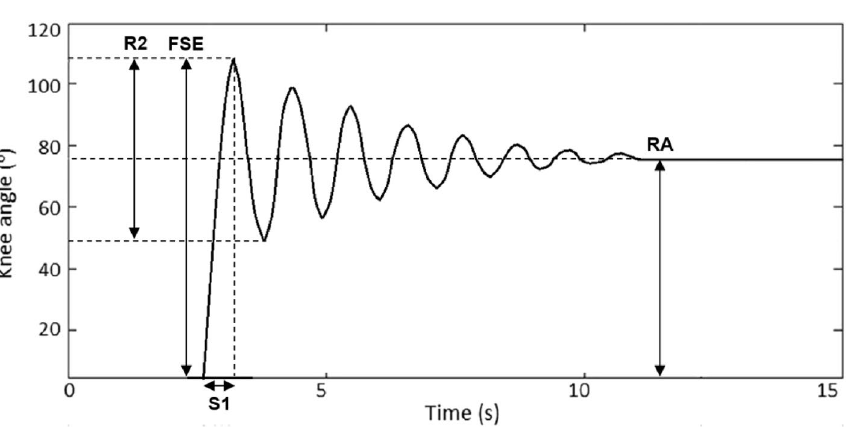
Figure 1. Setting of pendulum test. ( A ) Starting position: the leg was raised at the horizon of maximal knee extension with the subject in supine position. ( B ) Swing phase: after the leg totally relaxed, the heel is released and allowed to oscillate by the influence of gravity. ( C ) Resting position: when the oscillation stopped without visible movement, the difference of knee angle between the starting and resting position was measured as the resting angle (RA).